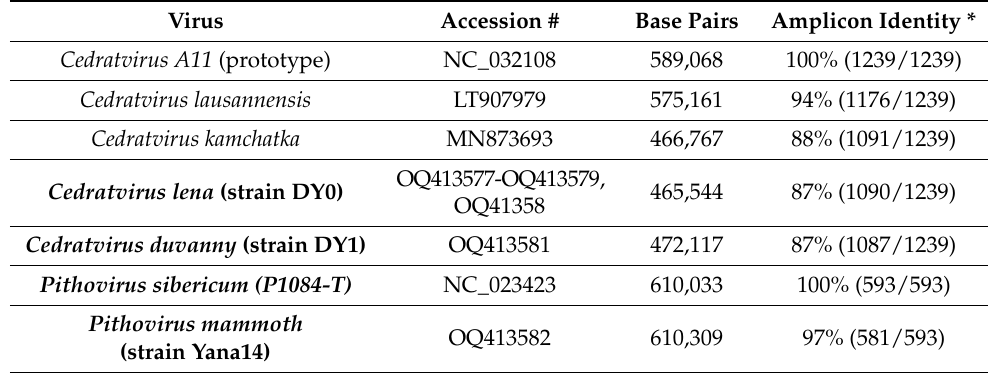
Table 4. PCR identification of previous and newly Cedratvirus and Pithovirus isolates. Virus Accession # Base Pairs Amplicon Identity * Cedratvirus A11